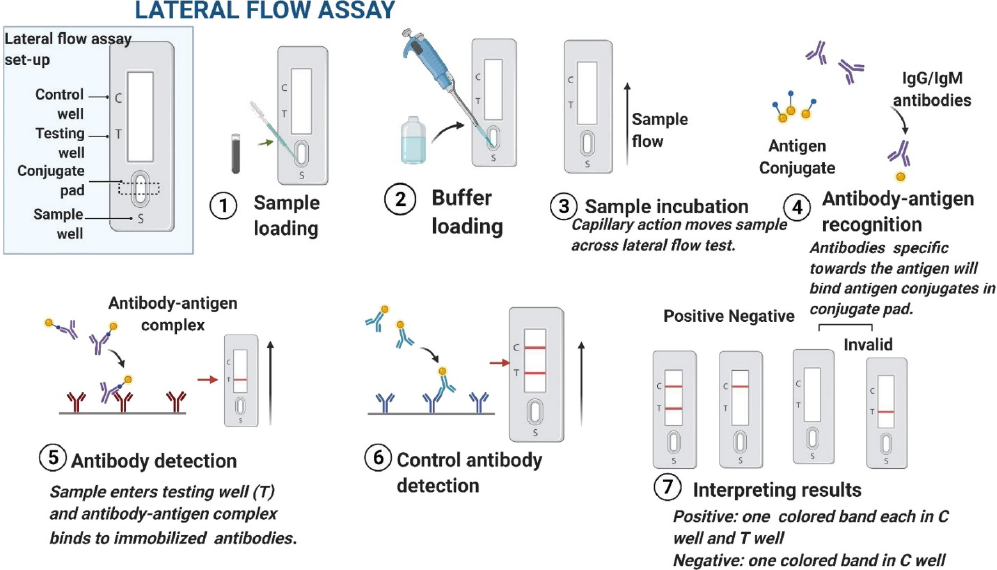
Figure 4. Process flow of an LFIA [176] Copyright © Elsevier, Patel et al.